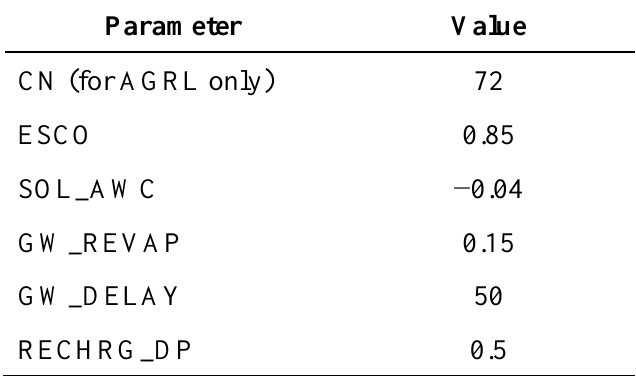
Table 3. Final calibrated values of SWAT parameters for Maquoketa River